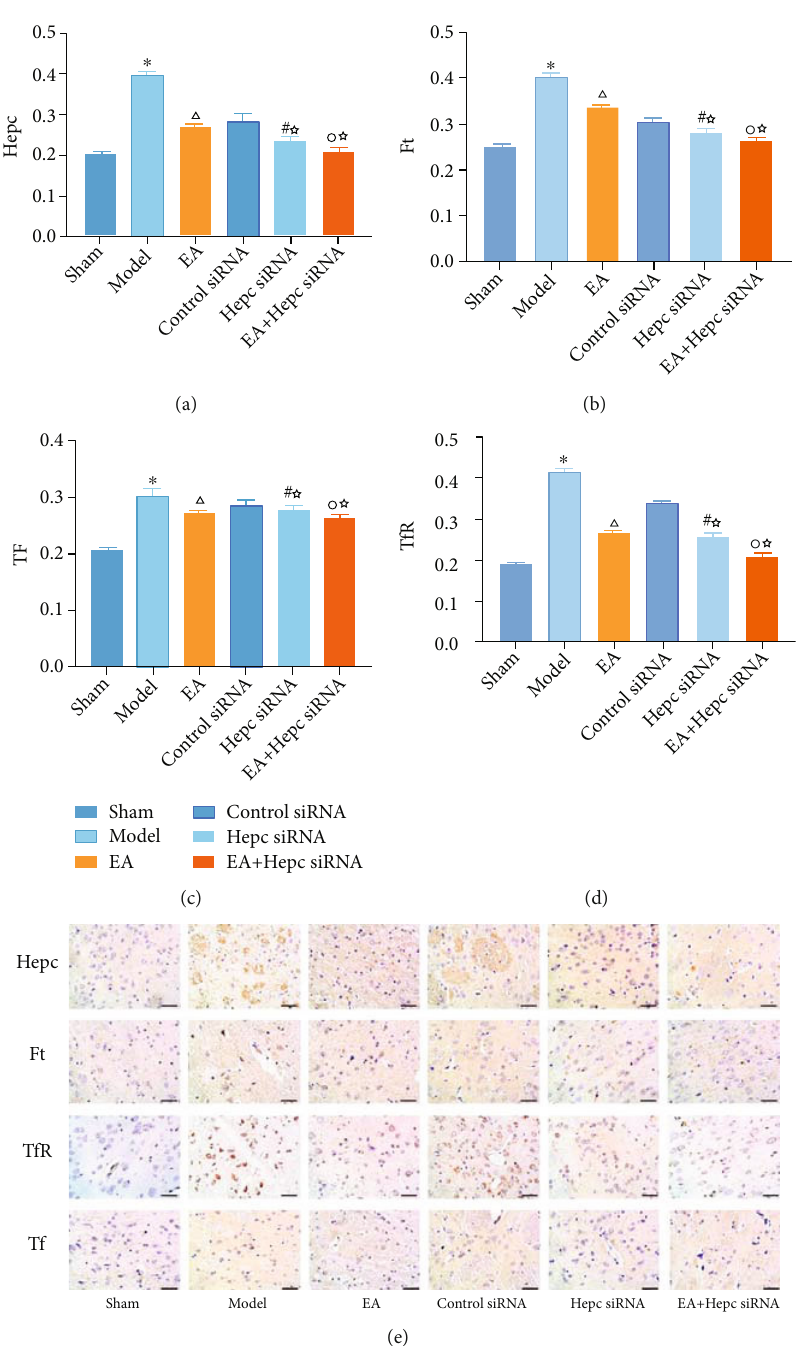
Figure 3: Immunohistochemical results of Hepc and Ft, Tf, and TfR in each group. Note: ∗ P < 0 : 01 vs. sham group, △ P < 0 : 01 vs. model group, ☆ P < 0 : 01 vs. EA group, # P < 0 : 01 vs. control siRNA group, and ○ P < 0 : 01 vs. Hepc siRNA